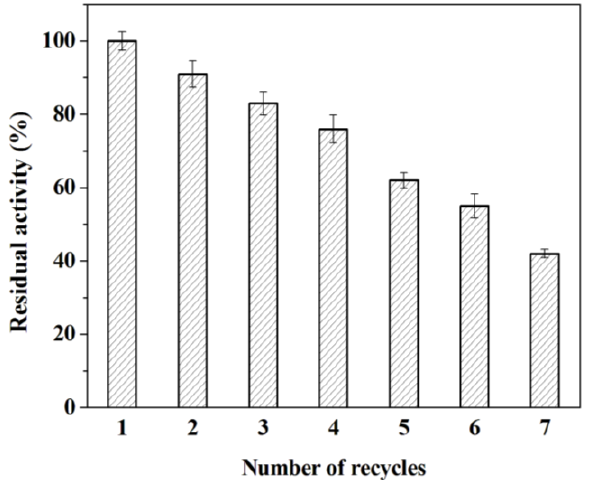
Figure 6. Catalyst recycling of the immobilized trypsin. The specific activity of immobilized trypsin (49.8 μmol min −1 g −1 ) in the first cycle was taken as control